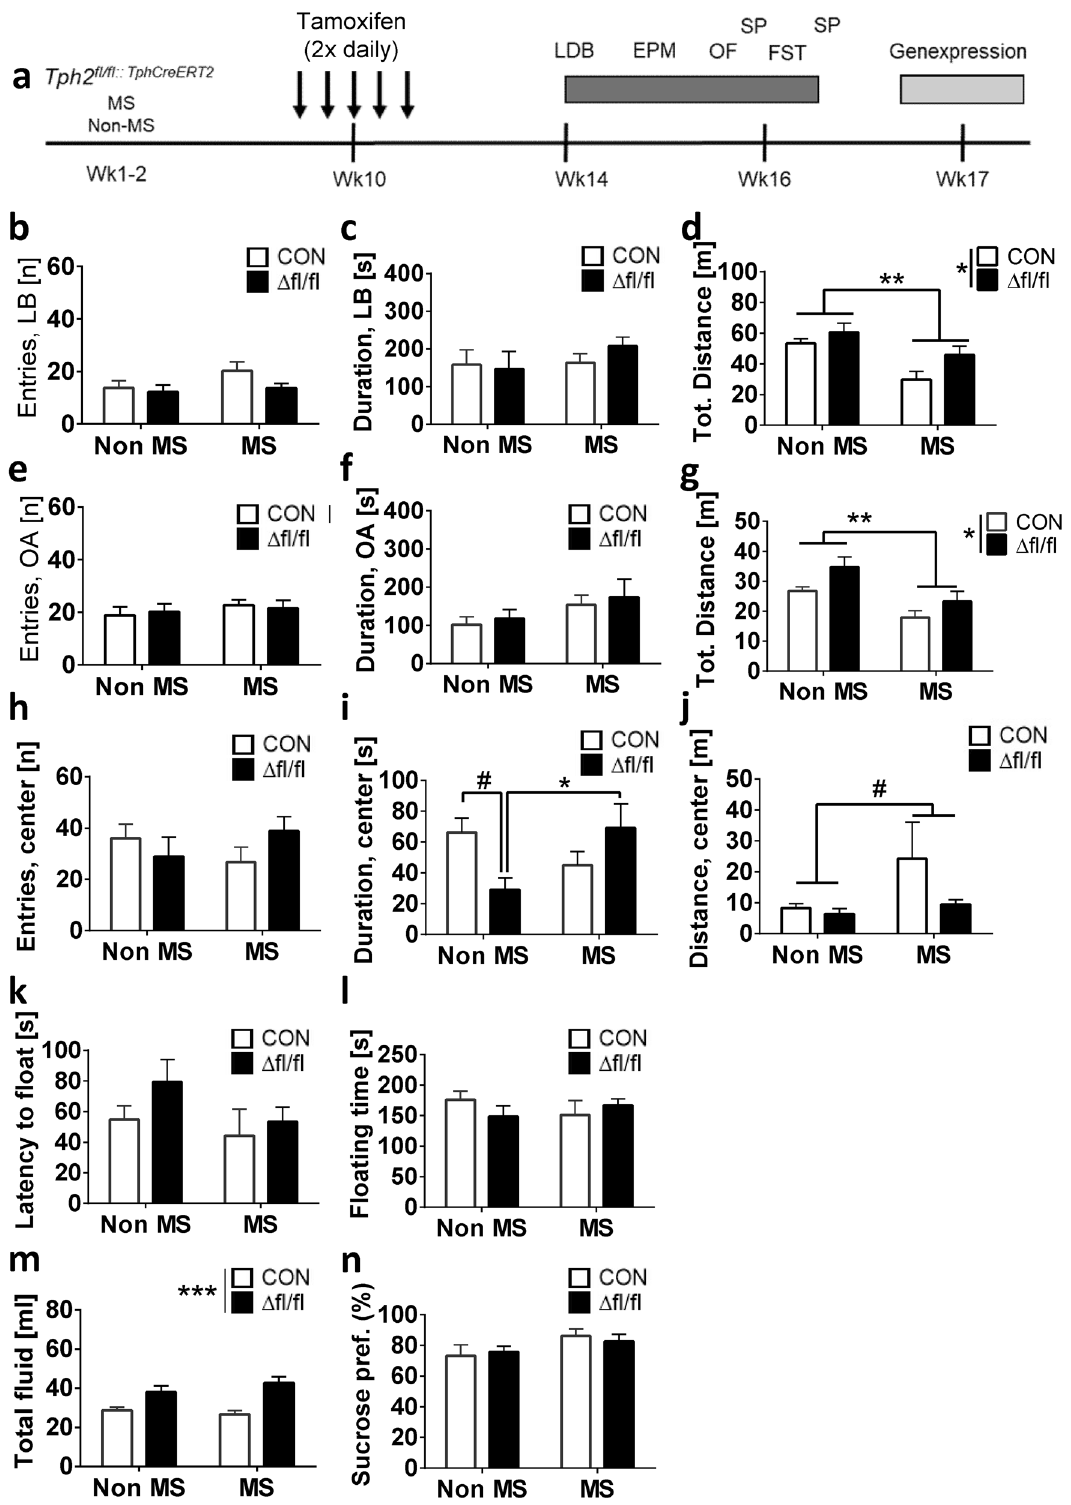
Figure 4. Anxiety-like, depression-like and exploratory behavior in MS-exposed Tph2 icKO mice with homozygous genetic predisposition ( Tph2 Δ fl / fl ). ( a ) Timelines for behavior testing; ( b )–( d ) LDB: light box visits, time in light box, total distance; ( e )–( g ) EPM: open arms visits, time in open arms and total distance; ( h )–( j ) OFT: center visits, time in center, total distance; ( k ),( l ) FST: latency to float and floating duration; ( m ),( n ) SPT: total fluid consumed and sucrose preference. Data are shown as mean ± SEM. #0.05 < p < 0.1, ** p < 0.01 and *** p <